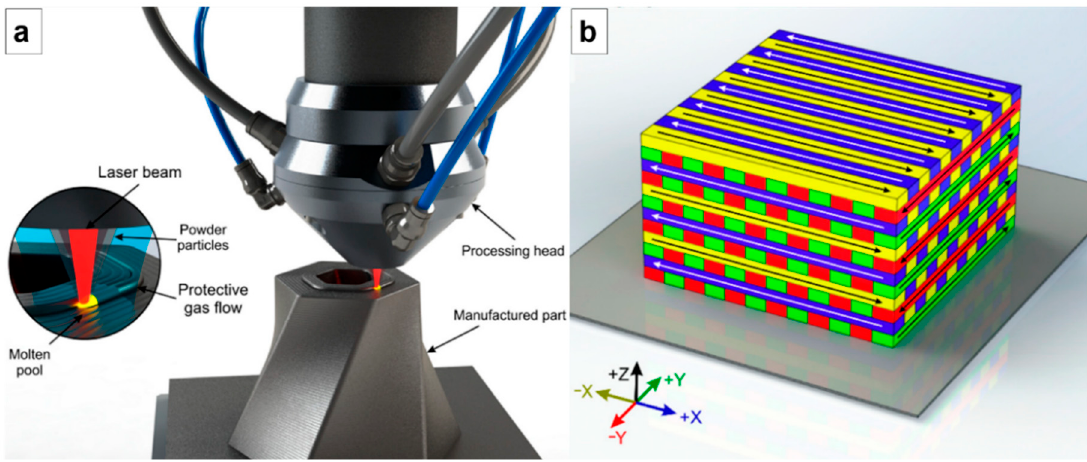
Figure 1. ( a ) Sketch of laser-directed energy deposition experimental configuration. ( b ) Tridimen- sional illustration of the scanning strategy employed to generate the laser-deposited specimens [36].